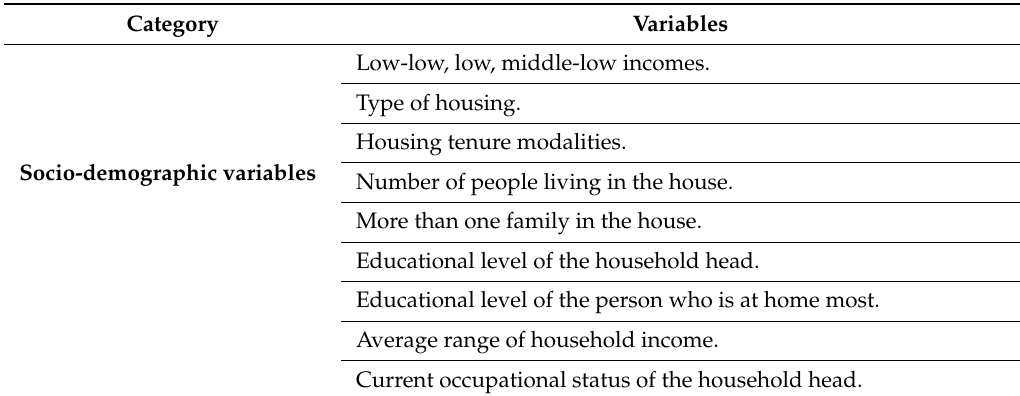
Table 1. Explanatory variables in the regression